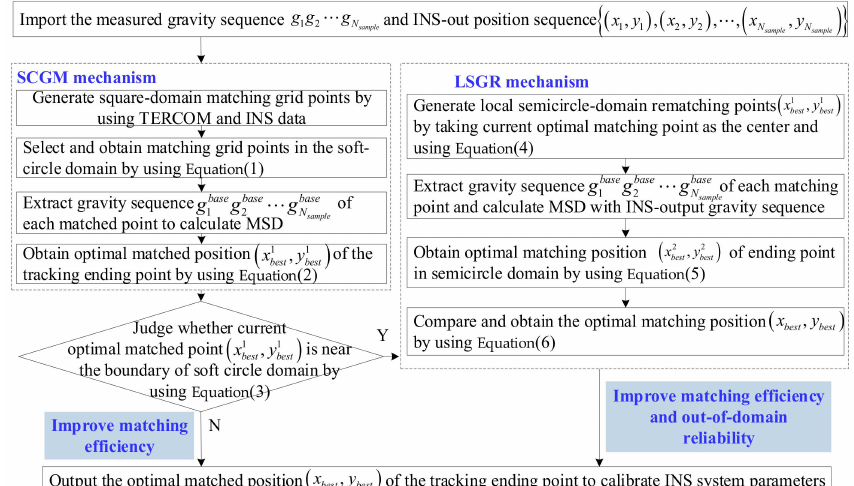
Figure 3. Implementation flow diagram of the proposed SLSR